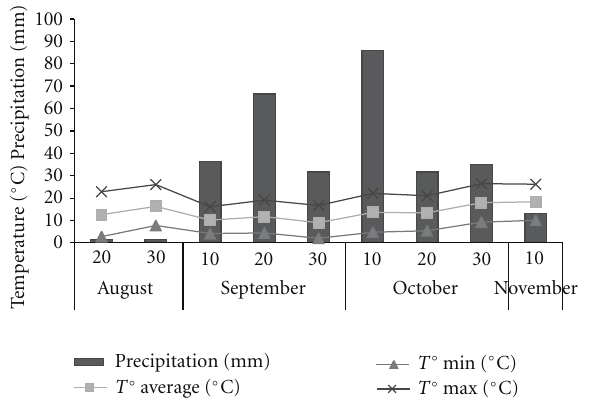
Figure 1: Average, minimum, and maximum air temperature values ( ◦ C) and precipitation during the 2009 growing season.